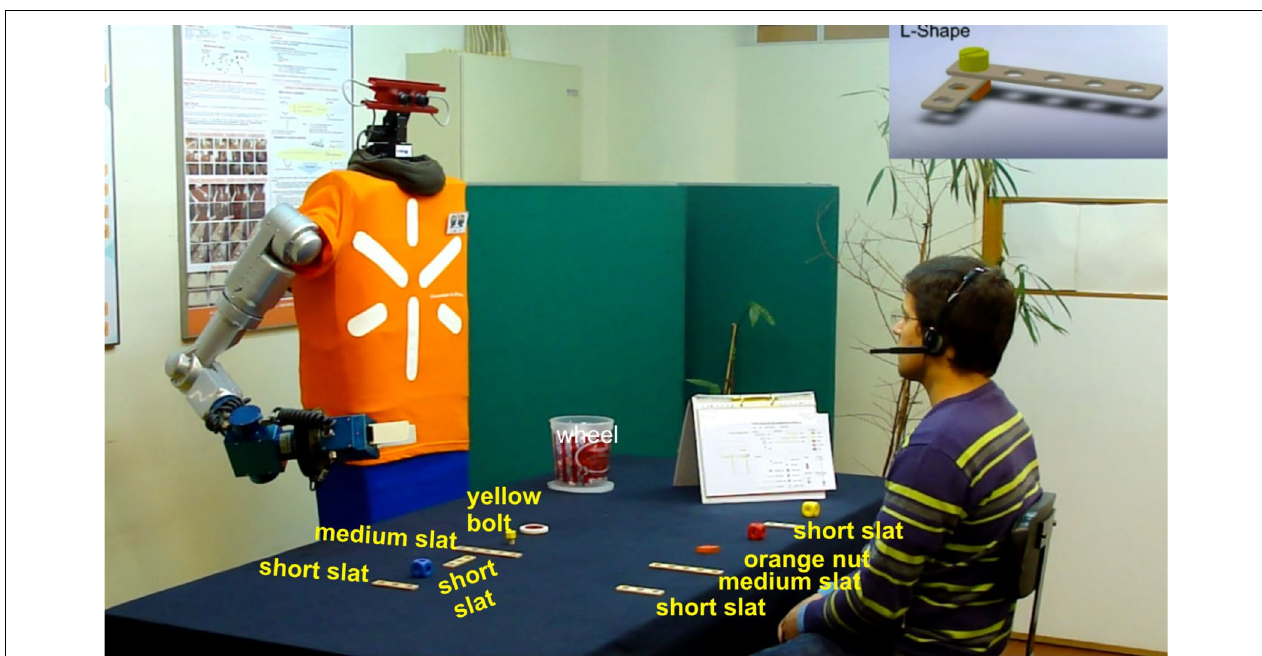
FIGURE 6 | Third example: initial distribution of components in the two working